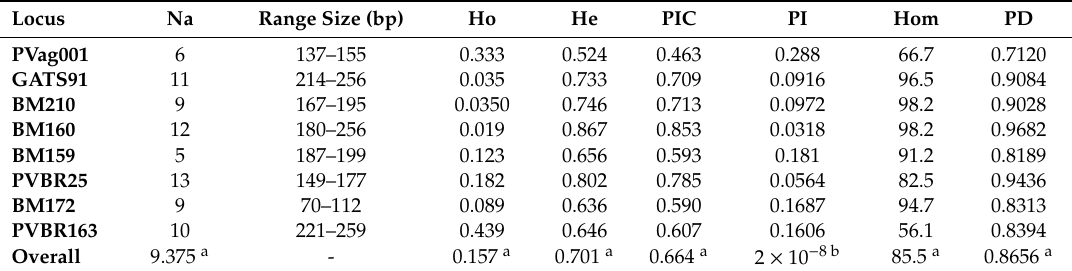
Table 1. Descriptive statistics of genetic variation for each locus. Number of alleles